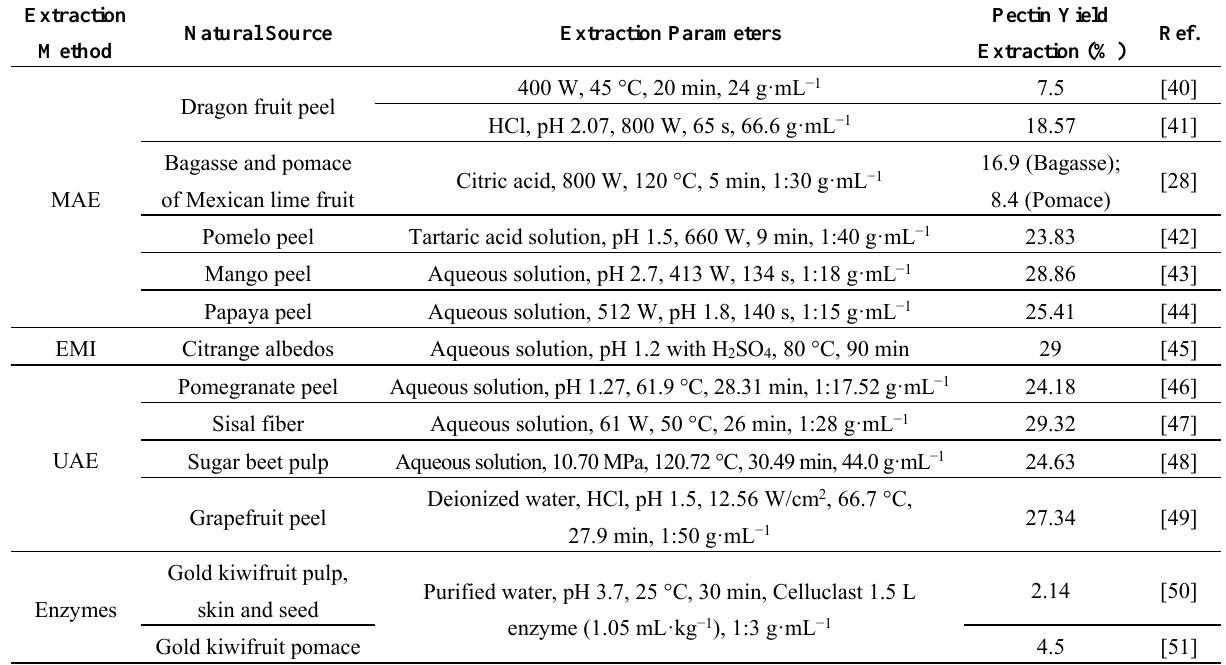
Table 2. Innovative extraction methods for